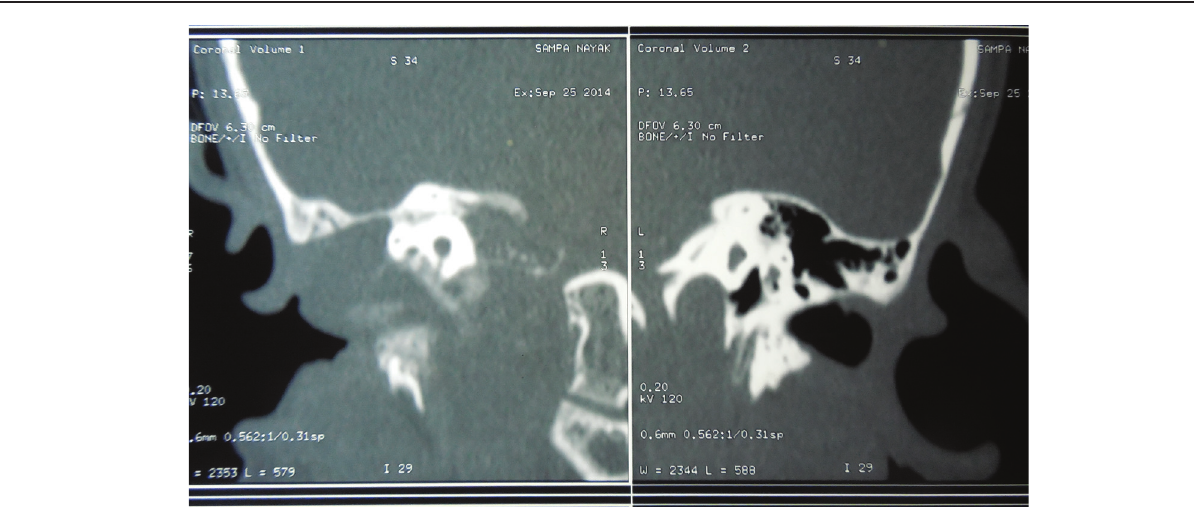
HRCT of the temporal bone coronal cuts showing tumour with